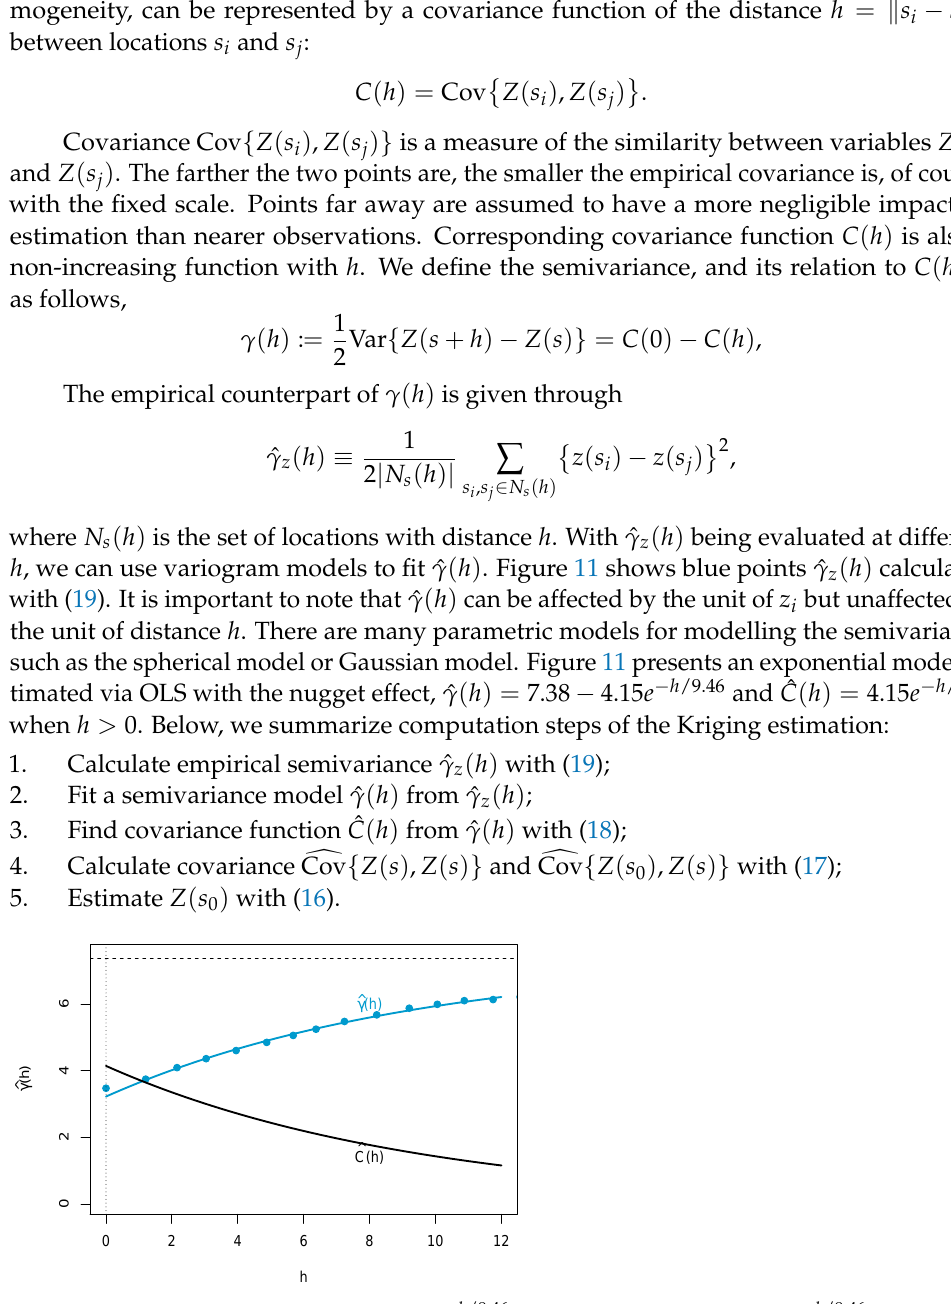
Figure 11. Semivariance ˆ γ ( h ) = 7.38 − 4.15 e − h /9.46 and Covariance C ( h ) = 4.15 e − h /9.46 when h >